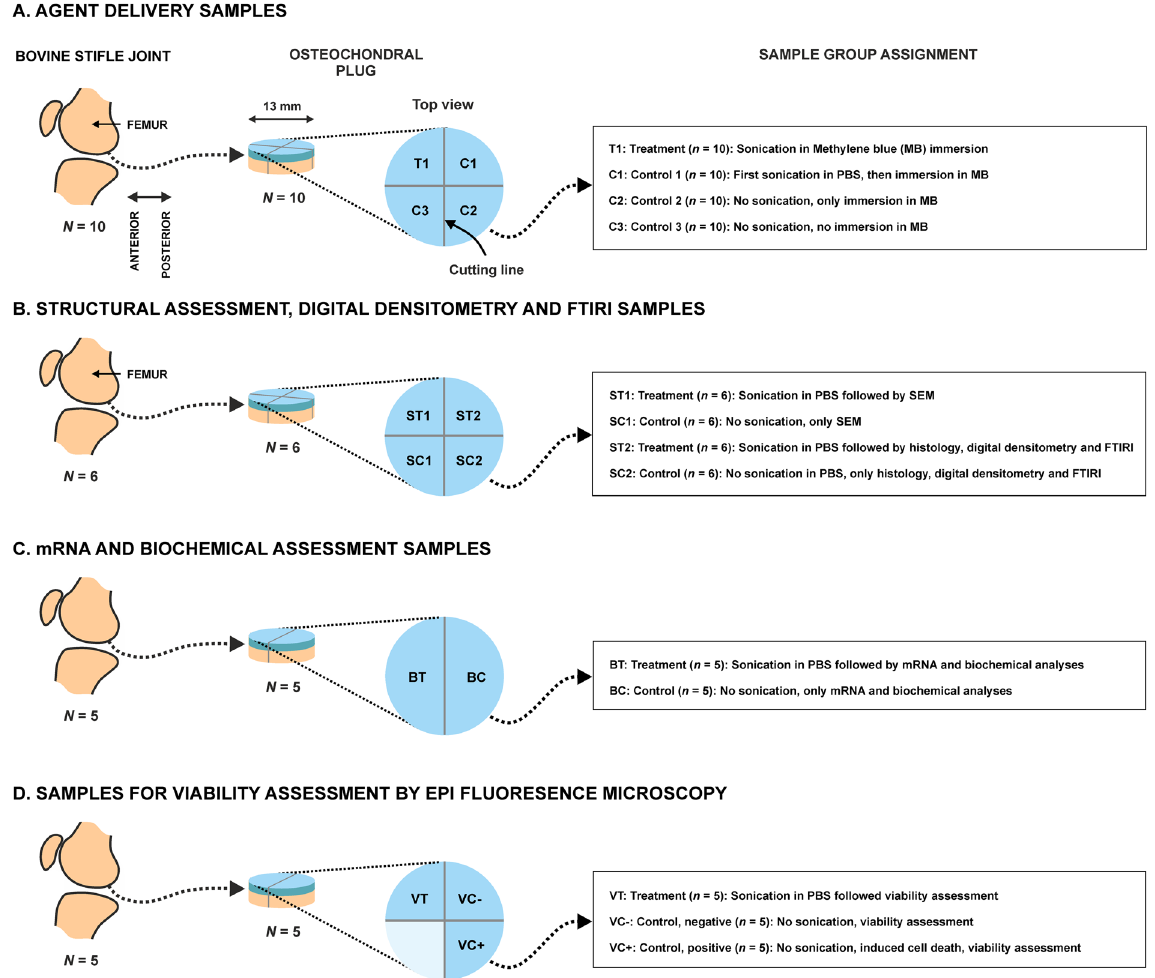
Figure 1. ( A ) Preparation and group assignment of agent delivery samples: Osteochondral plugs ( N = 10, Ø = 13 mm) were prepared from bovine stifle joints (one plug per joint, one joint per animal). The plug was then cut into four quadrants and randomized to the treatment group (T1) or control group (C1, C2 or C3). ( B ) Preparation and group assignment of structural assessment, digital densitometry and Fourier transform infrared imaging (FTIRI) samples: Osteochondral plugs ( N = 6, Ø = 13 mm) were prepared from bovine stifle joints (one plug per joint, one joint per animal). The plug was then cut into four quadrants and randomized to the treatment group (ST1 or ST2) or control group (SC1 or SC2). ( C ) Preparation and group assignment of mRNA and biochemical assessment samples: Osteochondral plugs ( N = 5, Ø = 13 mm) were prepared from bovine stifle joints (one plug per joint, one joint per animal). The plug was then cut into two halves and randomized to the treatment group (BT) or control group (BC). ( D ) Samples for viability assessment by EPI fluorescence microscopy: Osteochondral plugs ( N = 5, Ø = 13 mm) were prepared from bovine stifle joints (one plug per joint, one joint per animal). The plug was then cut into four quadrants. Three quadrants were randomized to the treatment group (VT), negative control group (VC − ) or positive control group (VC + ). One quadrant remained